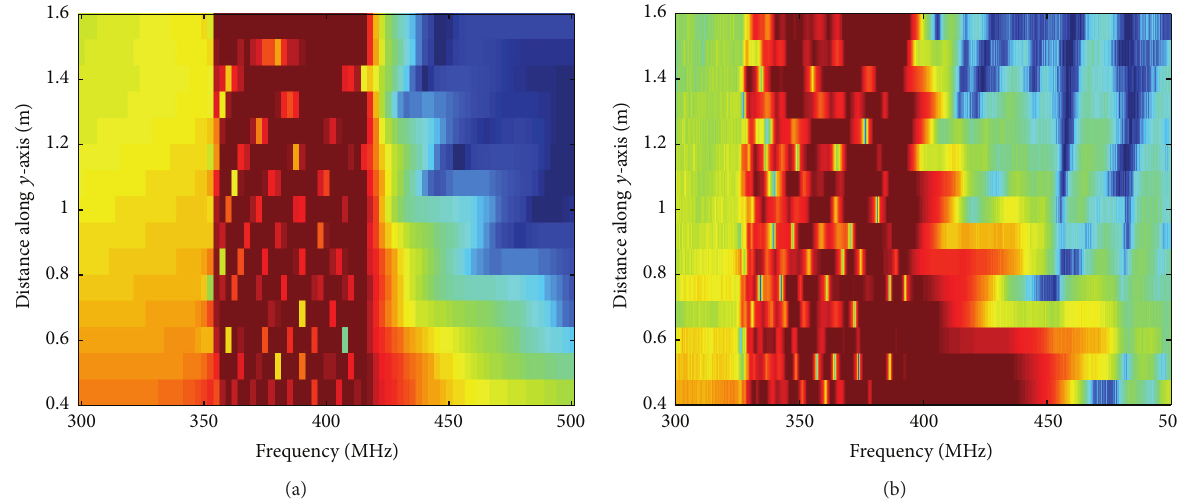
Figure 3: Normalized transmission coefficients: (a) simulation and (b) measurement.